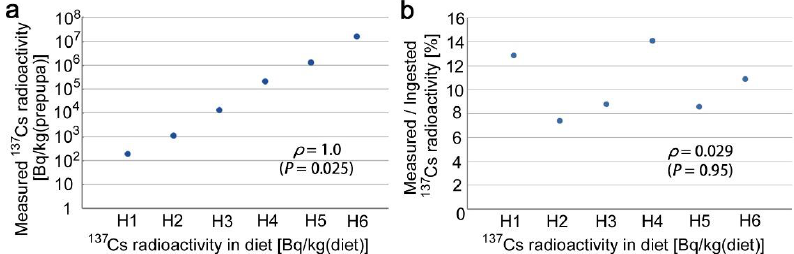
Figure 5. Caesium radioactivity in the prepupae. Spearman correlation coefficients and their associated P -values are reported. ( a ) Measured caesium radioactivity in the prepupae in proportion to that in the artificial diet. Both the x - and y -axes are on a logarithmic scale. ( b ) Percentage of the measured caesium radioactivity among the ingested caesium radioactivity plotted against the caesium radioactivity in the artificial diet. In this scatter plot, the x -axis is on a logarithmic scale.